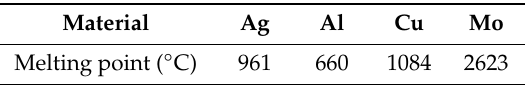
Figure 3. The reflectance spectrum of simulation metal films with a thickness of 150 nm. Table 1. The melting point of metals.